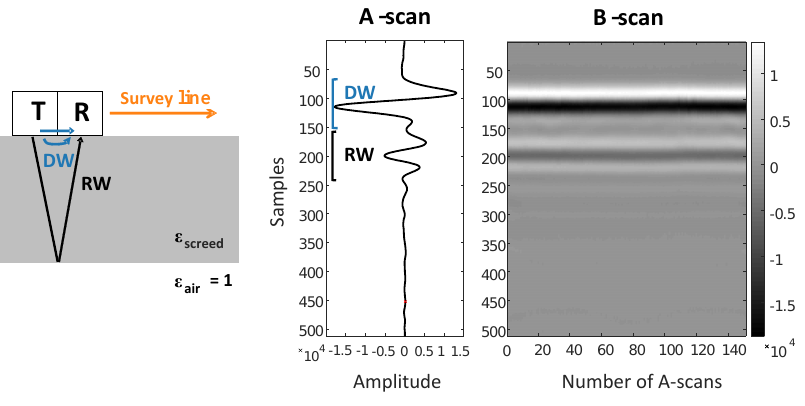
Figure 1. Principle of GPR. Multiple A-scans collected along a survey line form a B-scan.